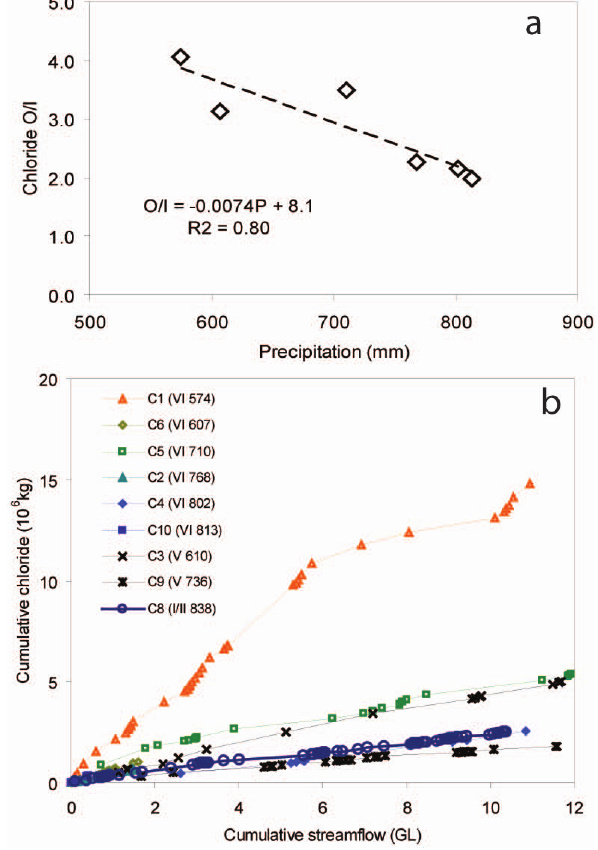
Fig. 8. (a) Catchment chloride ratio vs. catchment average annual precipitation for all type VI catchments, indicating that a catchment of an average precipitation of 960mm.yr − 1 would have now (2008) reached the new chloride equilibrium (type II). (b) Cumulative chlo- ride load in the stream water vs. cumulative streamflow for six type VI catchments, showing that the average chloride concentration (the slope of the curve) decreases with increasing annual precipitation (the number in the legend), with two type V catchments and one chloride equilibrium catchment for comparison.